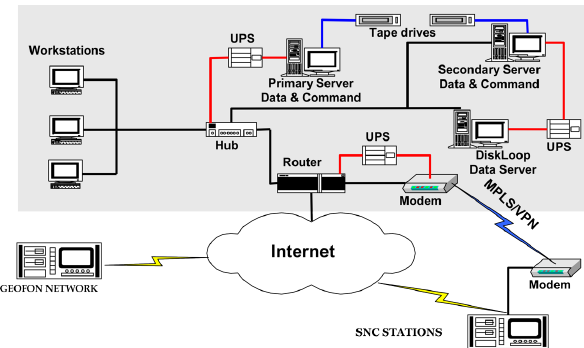
Fig. 5. Schematic topology of the Network Centre for Data Storage and Analysis Centre (NCDSA) of HSNC.